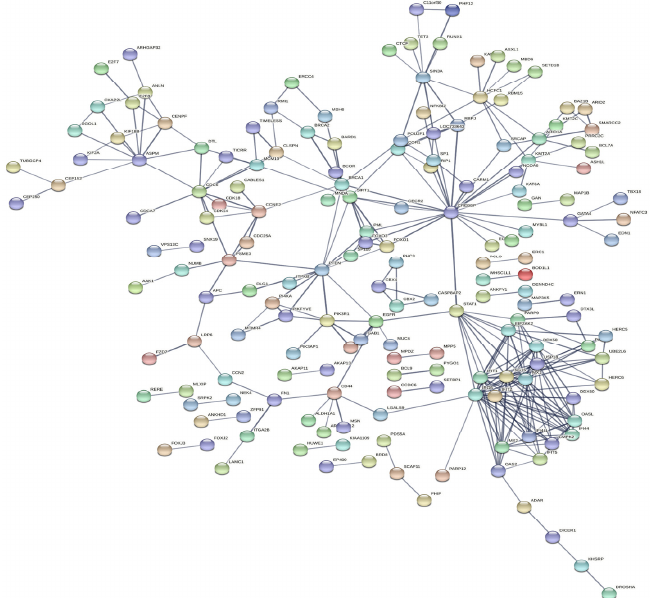
Figure 6. PPI analysis of the upregulated DEGs in the E. coli and E. coli + pBD2 groups.